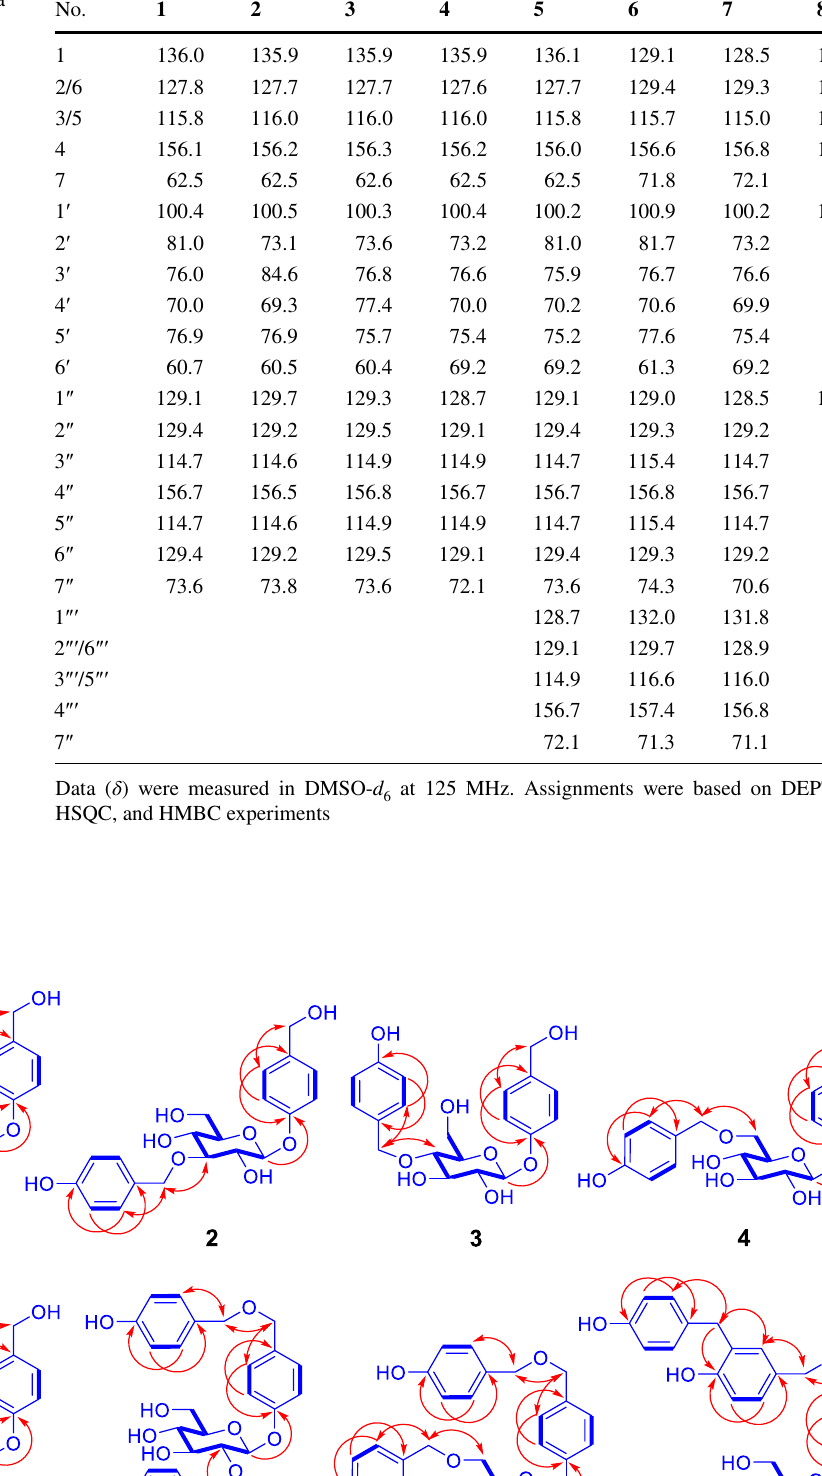
Table 2 13 C NMR spectral data